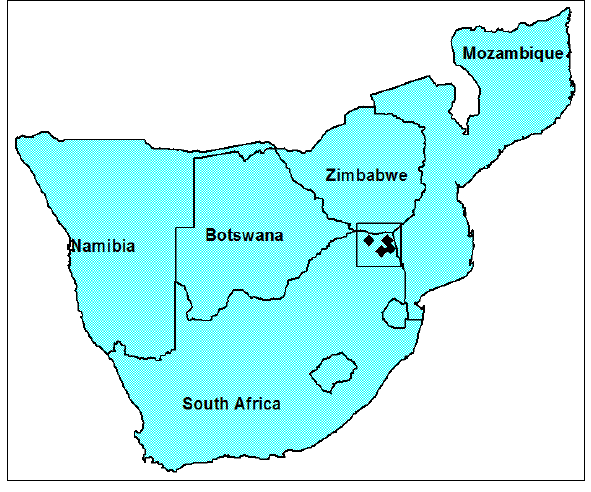
Figure 1: A map of southern Africa showing the location of the four 13 C baobab trees (inside the square area as indicated) whose δ data were used in this study. Samples obtained were large enough to separate individual ring structures at 1-year intervals. Woodborne et al. 17 subsequently performed an accelerator mass spectrometry radiocarbon analysis of these samples and calibrated the dates using well-known standards and 13 C data to confirm abnormal dry procedures. They used the extracted δ conditions during the Little Ice Age, particularly during 1635 and 1695. 13 C data were obtained from Woodborne et al. 24 (http://www.ncdc. The δ Figure 3: A Morlet wavelet power spectrum of the Pafuri noaa.gov/paleo/study/17995). Figure 2 shows the data between AD between 1600 AD and 1700 AD, showing the behaviour of the 1600 and 2000 utilised in this investigation. Schwabe (~11-year) and Hale (~22-year) solar periodicities during this interval. The white contour line represents the 95% confidence level. The top plot shows the annual From Figure 3, the 11-year Schwabe sunspot cycle as well as the